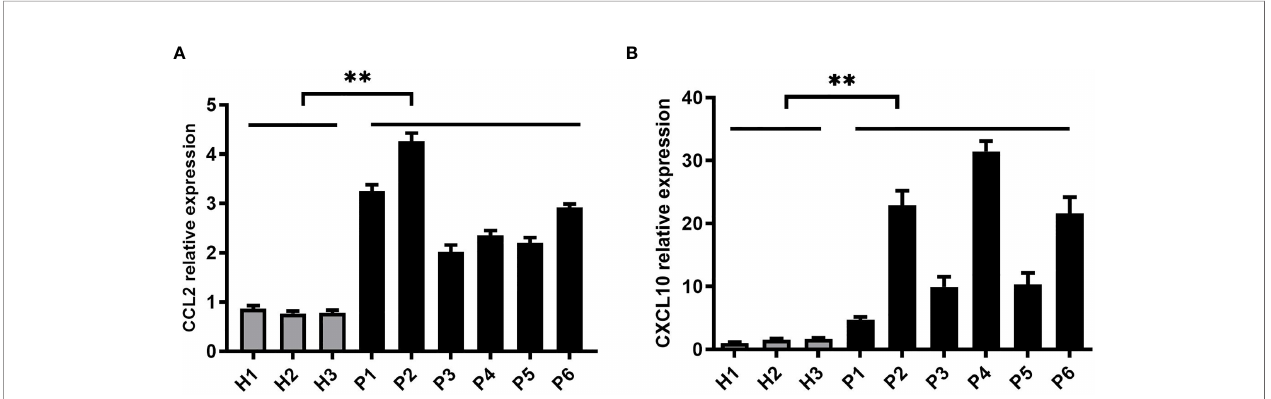
FIGURE 5 | CCL2 and CXCL10 expression is signi fi cantly increased in liver biopsy samples of HCV patients. (A, B) Six liver biopsy samples from patients infected with HCV and three control samples from healthy liver tissues were collected. The samples were handled in BSL-2 laboratory using standard precautions. Relative expressions of CCL2 and CXCL10 were determined by quantitative real-time PCR (qPCR). Data are shown as mean ± SD for three independent experiments. ** p <